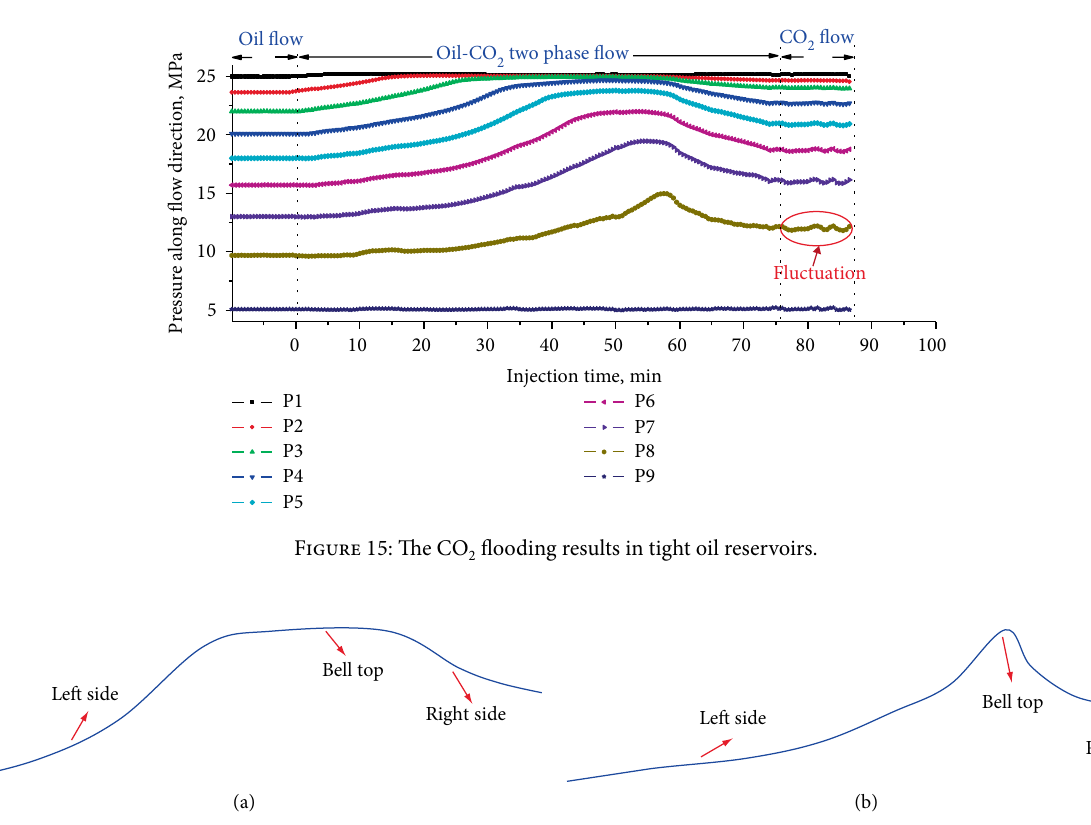
16: Pressure curves schematic of monitoring points (P2–P8): (a) P2–P6 and (b)